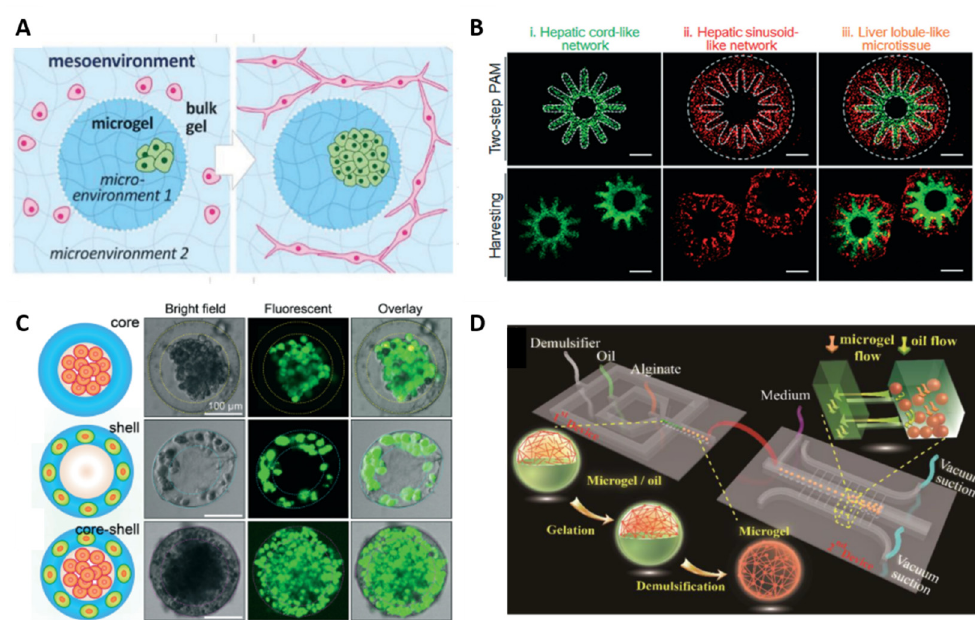
Figure 1. Various strategies to mimic the structural complexity of living tissues using compart- mentalized CLMs. ( A ) Schematic of microgel-in-gel system which allows for adjusting micro- and mesoenvironmental parameters. Republished with permission of Royal Society of Chemistry, from Ref. [44]; permission conveyed through Copyright Clearance Center, Inc. ( B ) Radially orchestrated networks resembling (i) hepatic cords and (ii) hepatic sinusoids and their assembly in (iii) 3D liver lobule-like microtissue. Scale bars, 500 µ m. Republished with permission of Royal Society of Chem- istry, from Ref. [45]; permission conveyed through Copyright Clearance Center, Inc. ( C ) Assembly of different cells in the 3D core-shell microgel. HepG2 cells were confined in the core whereas NIH-3T3 fibroblasts were immobilized in the shell. The scale bars are 100 µ m. Republished with permission of Royal Society of Chemistry, from Ref. [43]; permission conveyed through Copyright Clearance Center, Inc. ( D ) Schematic representation of microfluidic chip with two individual sub-devices: the first one is exploited for microgel droplet generation, in the second one it takes place the emulsification and the culture of cell-laden microgel under dynamic conditions. Reprinted with permission from Ref. [26]. Copyright 2019 American Chemical Society. Table 1. Latest representative works of compartmentalized CLMs for micro-organs formation. Ref.